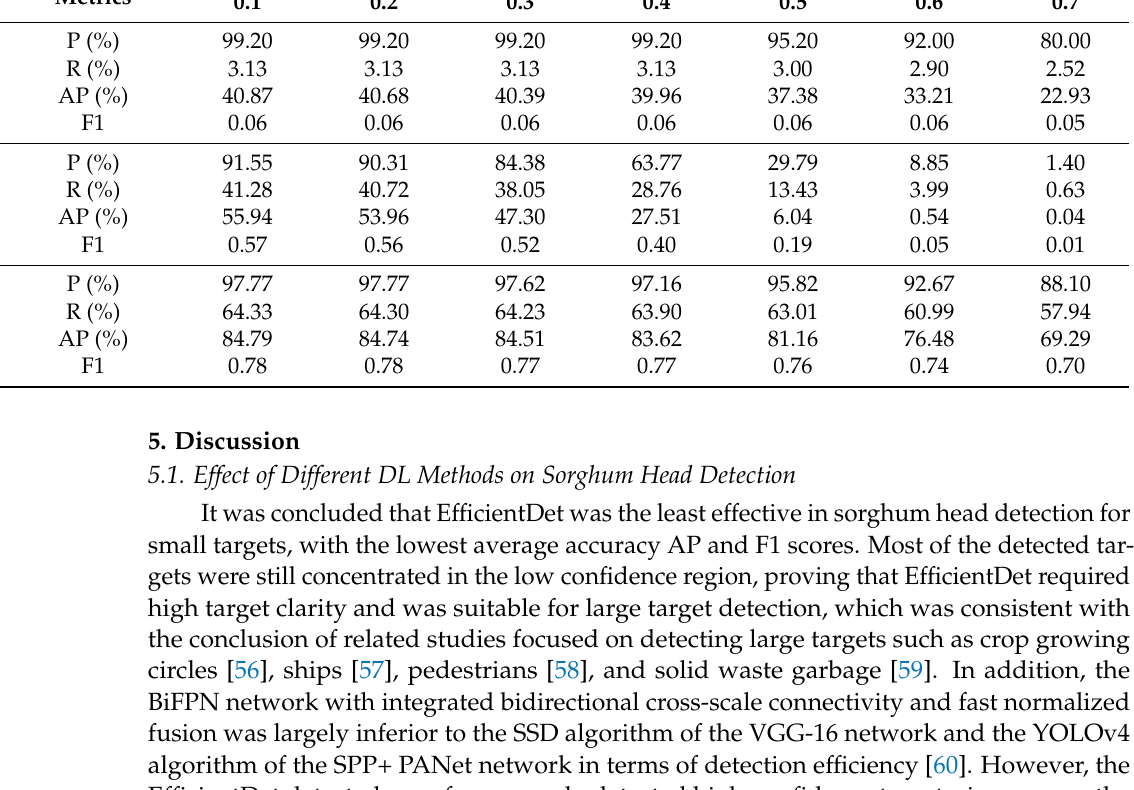
Table 5. Performance evaluation results of each method with different IoU thresholds.